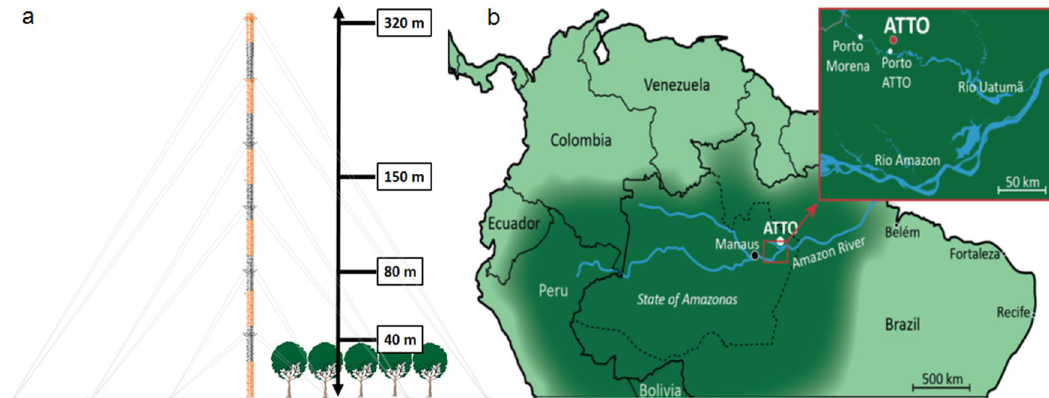
Fig. 1 Height and location of the ATTO tower. Composite fi gure showing the sampling heights chosen for the VOC measurements at the ATTO tower relative to the canopy height ( a ) and the location of the fi eld site ATTO relative to the city of Manaus, the Amazon river and its af fl uent the Uatumã River ( b ). Map drawn by Iris Moebius,